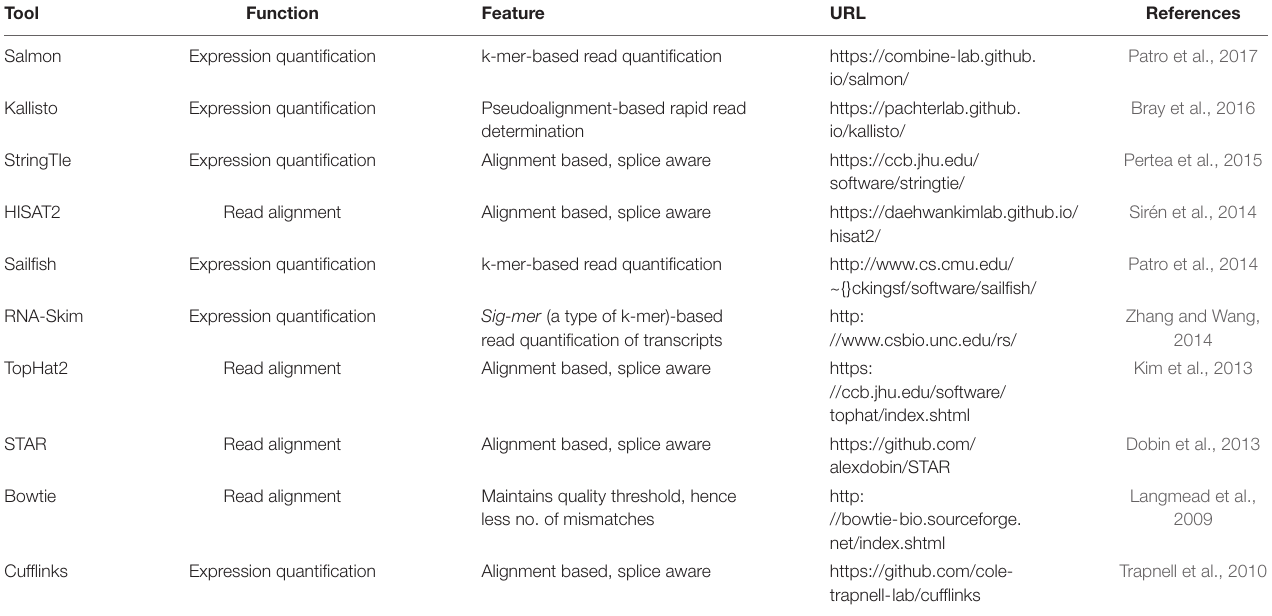
FIGURE 1 | Single-cell analysis in disease and health. Starting from the dissociation of target cells from the target tissue/organ, their isolation based on fluorescence-activated cell sorting (FACS) or other microfluidic techniques to RNA extraction. The RNA extraction is followed by cDNA synthesis by reverse transcriptase, followed by amplification and sequencing. From the sequencing, the reads are aligned and subjected to quantification that results in a quantification matrix or Gene Expression Matrix. TABLE 4 | Widely used tools for read alignment and expression